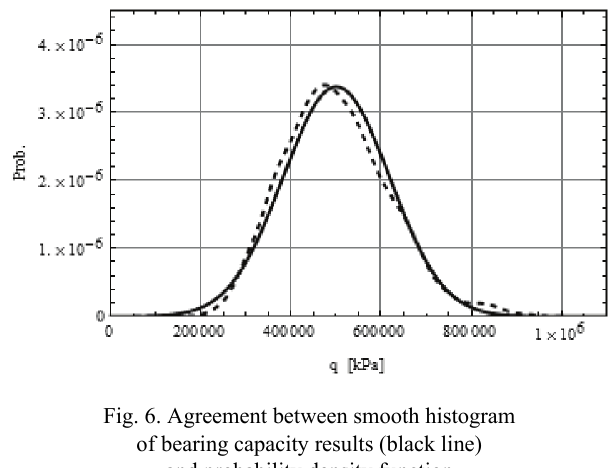
of bearing capacity results (black line) and probability density function for respective normal distribution (dotted line),  = 1.0 m